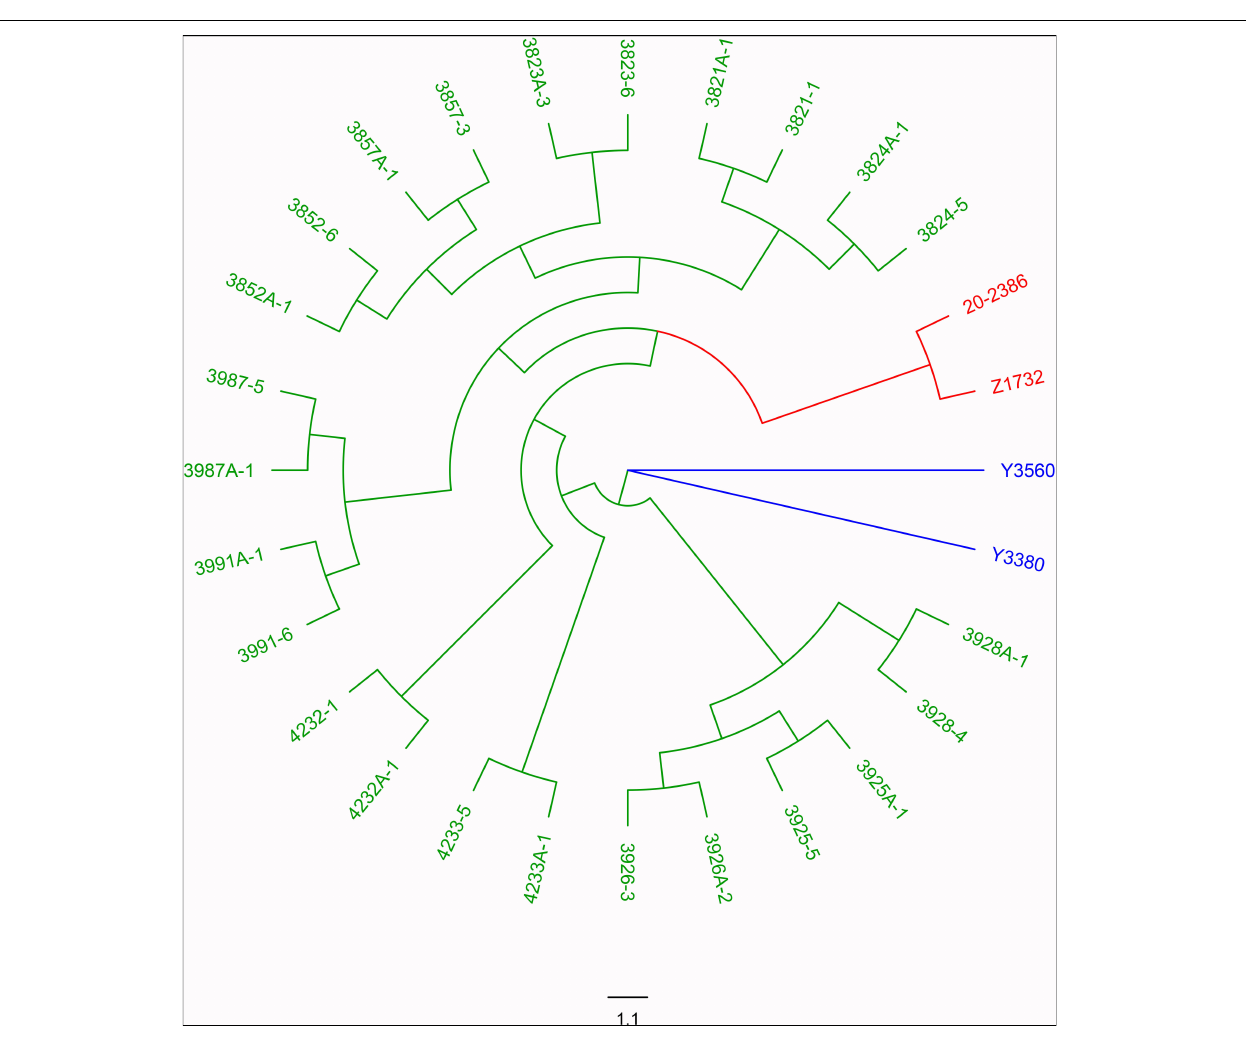
FIGURE 5 | Genetic clustering analysis of F 2 generations produced by induced heterozygous females. The induction lines Y3560 and Y3380 are in blue, the hybrid control is in red, and the induced F 2 generation is in